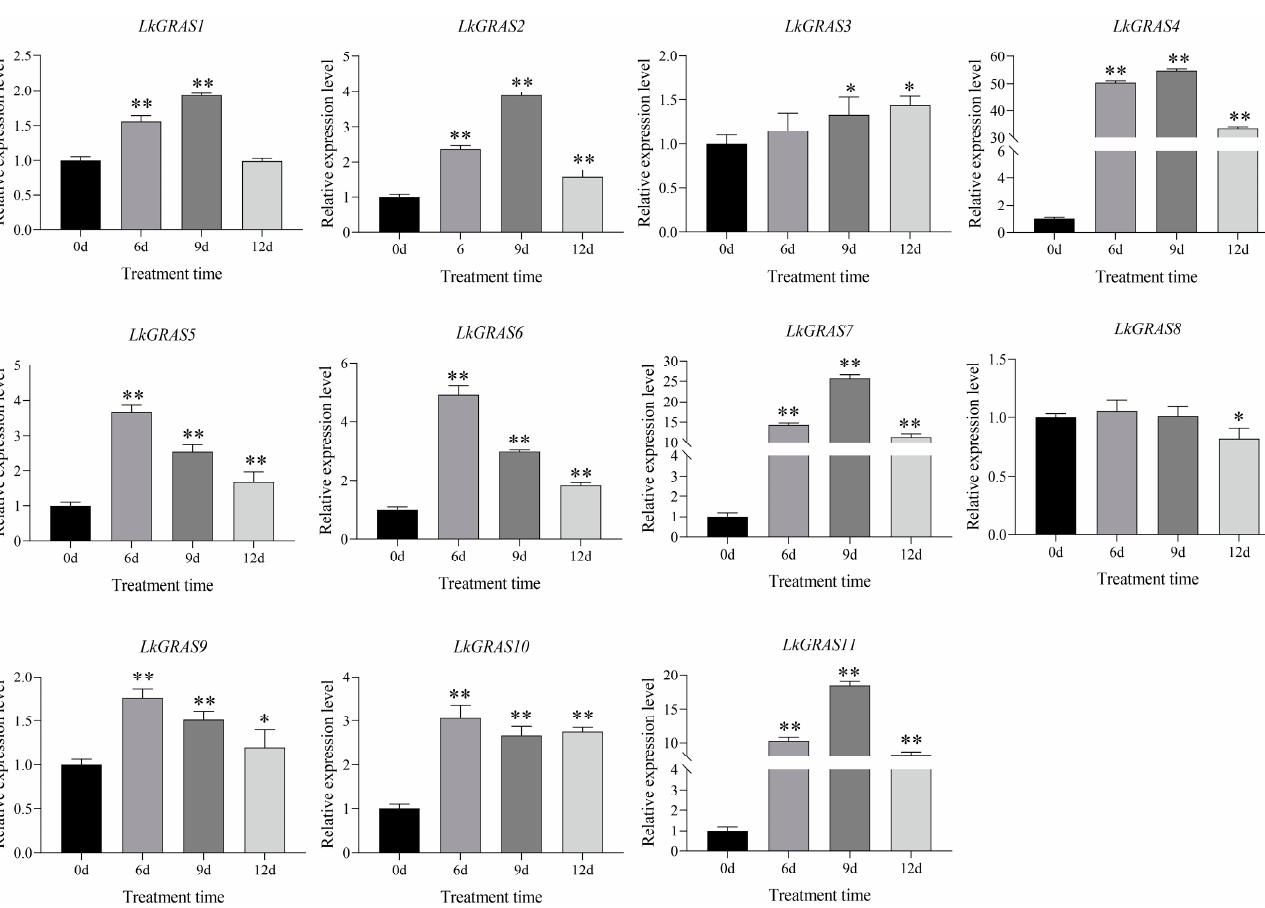
Figure 6. The relative expression levels of the LkGRAS genes in needles under drought stress using qRT-PCR. Error bars represent the deviations from three biological replicates. The x -axis represents the time points after drought stress (* p < 0.05, ** p <